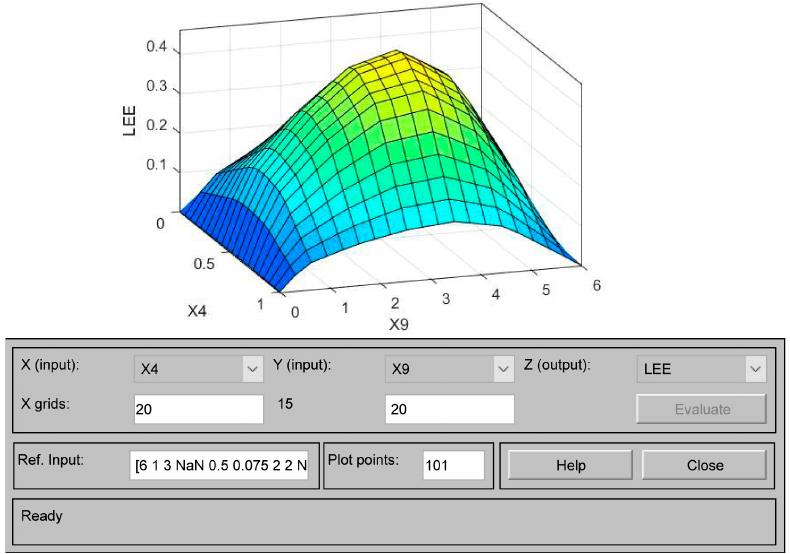
Figure 7. Dependence of LEE (x 4 ,x 9 ) on the degree of use of load capacity (x 4 ) and time interval (x 9 ) for vehicle of category N3.